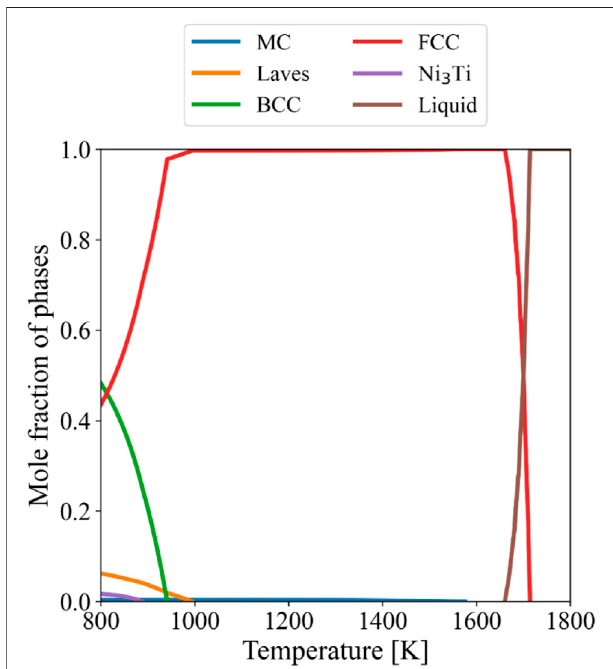
FIGURE 8 | Calculated equilibrium phase fractions for the 18Ni300 composition at 1 atmospheric pressure.